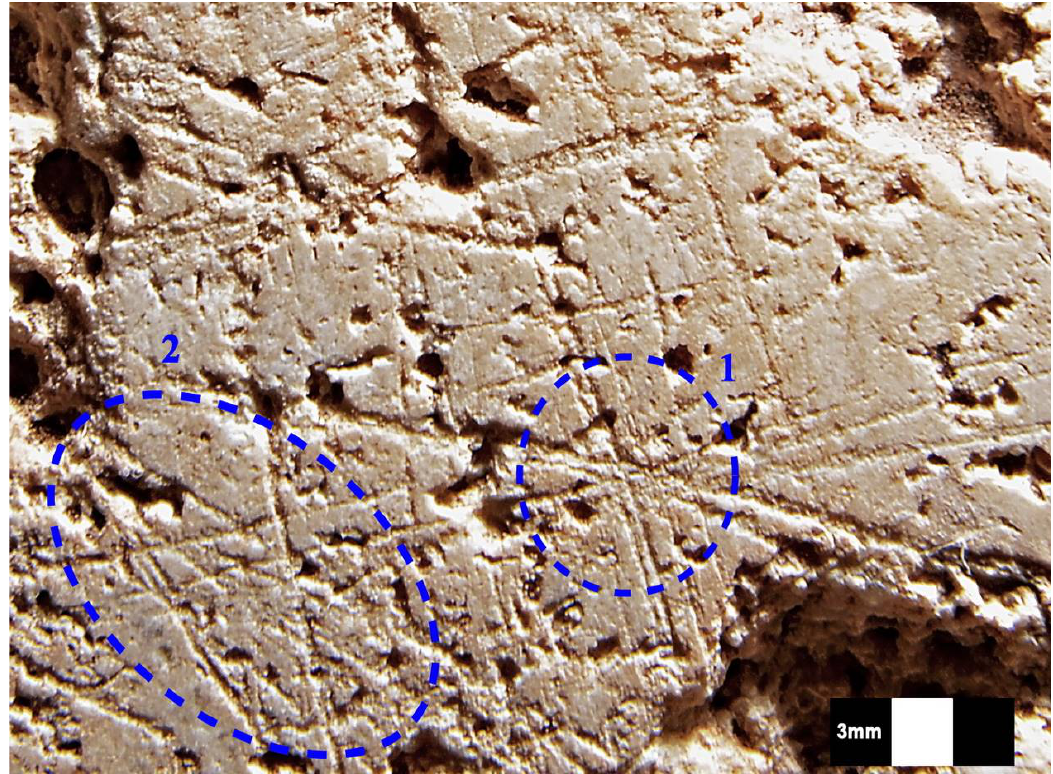
Figure 12. A view of a preserved section with incisions. Note the double lines within the marked areas (1, 2), as well as the vertical lines crossing the horizontal ones in both marked locations (photograph by E. Crater Gershtein).